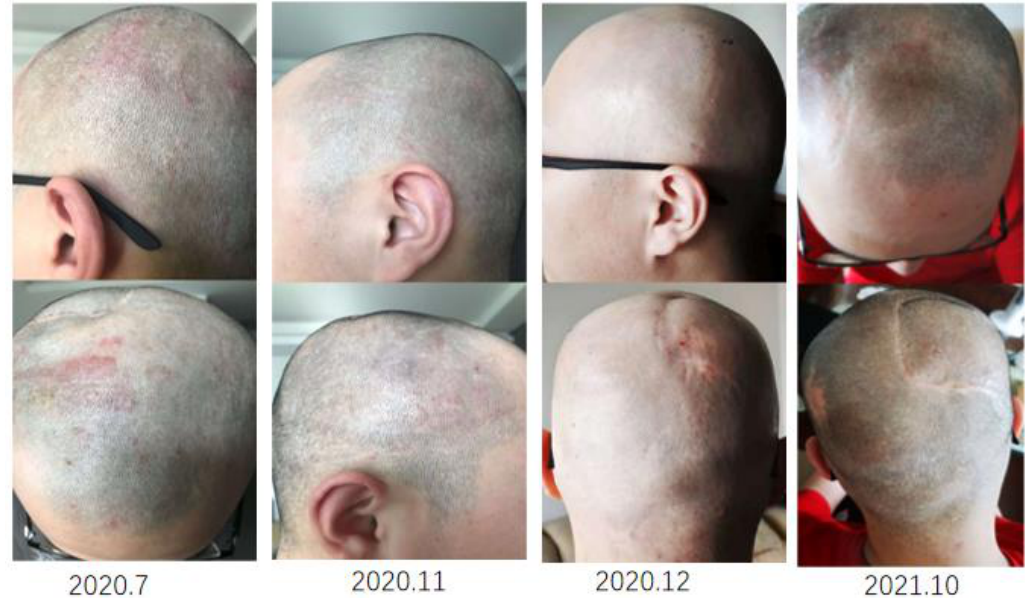
Figure 4. The picture of the patient’s head rash at the beginning and after treatment.